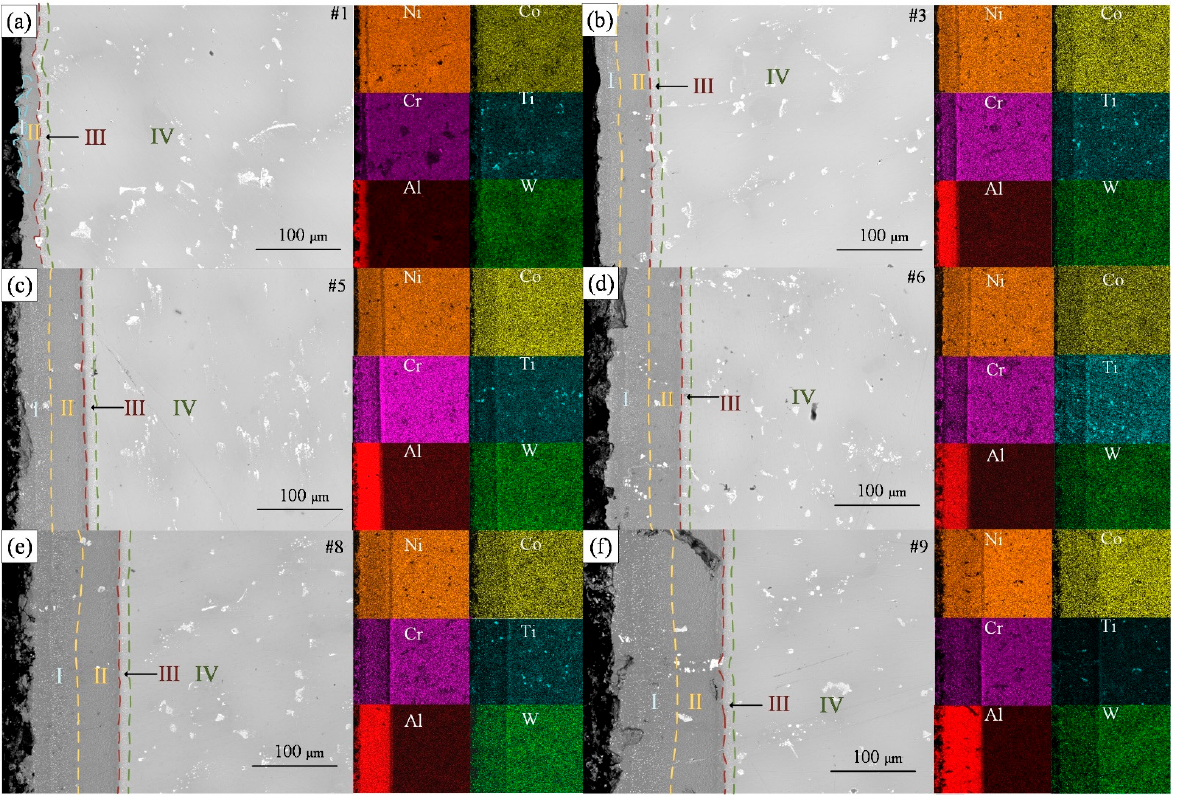
Figure 4. BSE cross-sectional images of different thicknesses of aluminized coatings on the surface of DZ22B alloy. ( a ) 23 ± 9 μ m, ( b ) 60 ± 5 μ m, ( c ) 85 ± 5 μ m, ( d ) 89 ± 6 μ m, ( e ) 109 ± 12 μ m, ( f ) 136 ± 13 μ m.